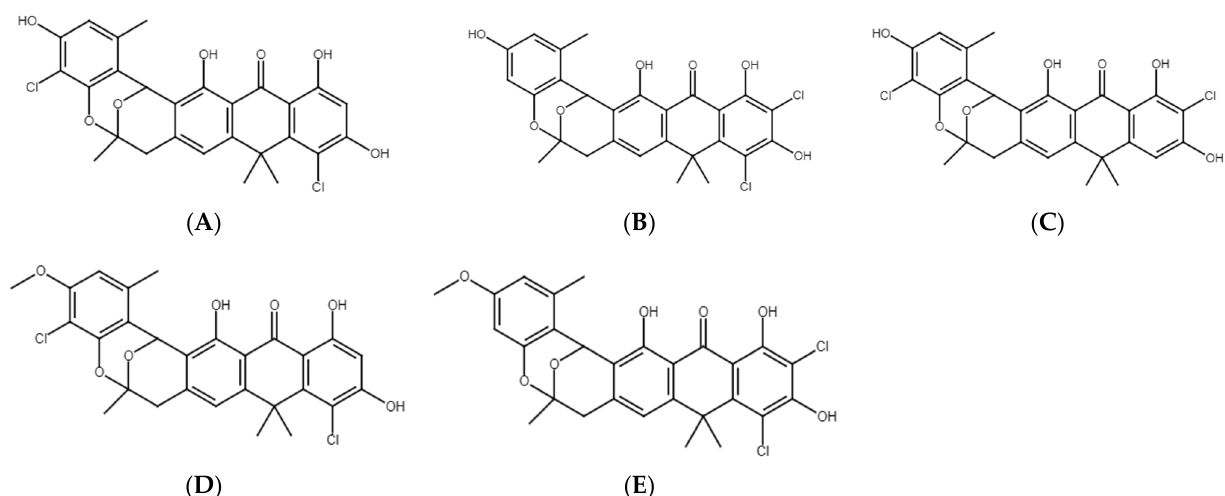
Figure 9. Chemical structures of the preliminarily detected natural products produced by Streptomyces isolates M2_9, M4_24, and M5_8. ( A ) 4,10-Dichloroanthrabenzoxocinone, ( B ) 10,12-Dichloroanthrabenzoxocinone, ( C ) 4,12-Dichloroanthrabenzoxocinone, ( D ) 4,10-Dichloro-3-O-methylanthrabenzoxocinone, ( E ) 10,12-Dichloro-3-O-methylanthrabenzoxocinone.